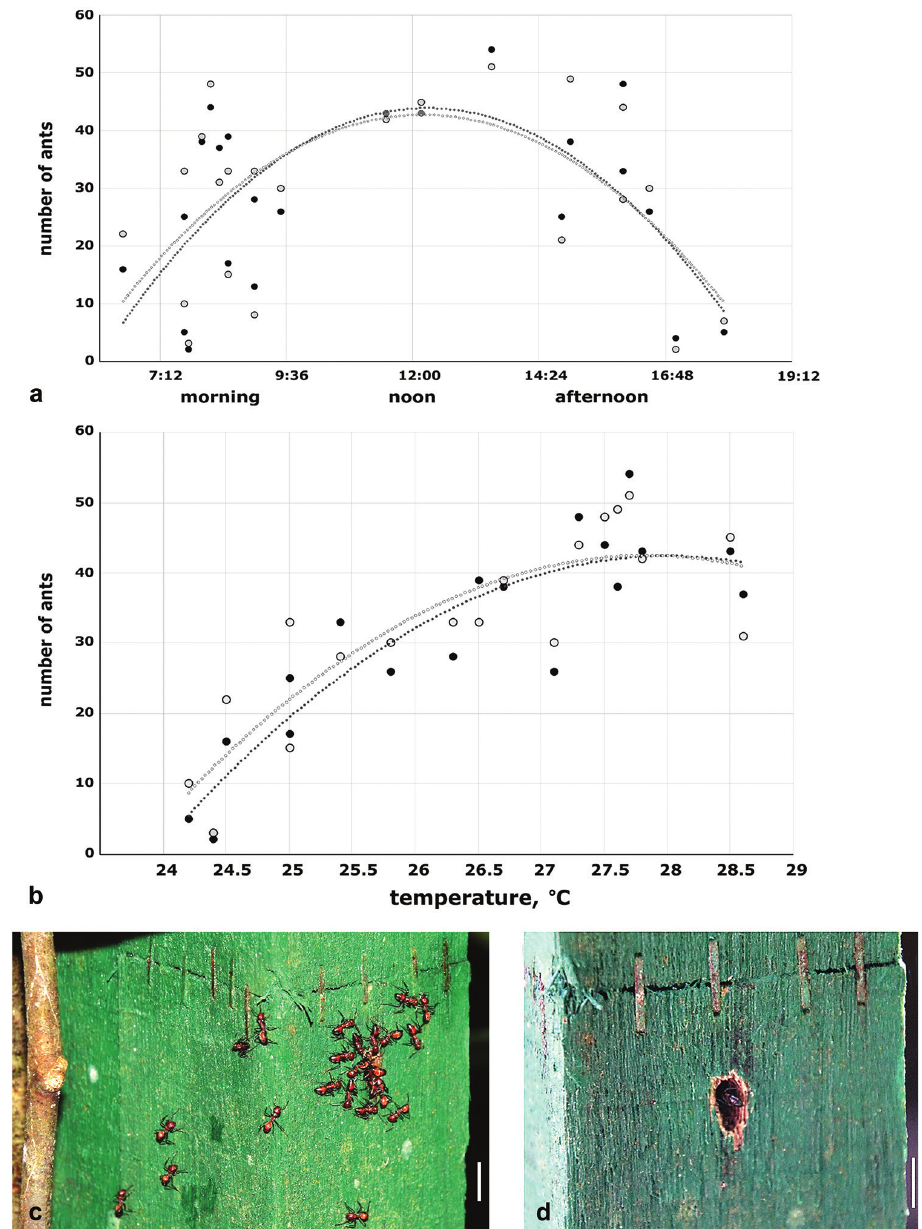
Figure 9. Activity of C. explodens sp. n. at the entrance to the artificial nest #38. a Scatter plot of the number of minor workers entering (black dots) and leaving (open dots) the nest depending on the time of day b Scatter plot of the number of minor worker ants entering (black dots) and leaving (open dots) the nest depending on the air temperature. Polynomial trend lines on a and b are shown for the numbers of entering (black) and exiting (grey) minor workers c and d show high and low worker activity near the entrance of nest #38, respectively; white bars denote 1